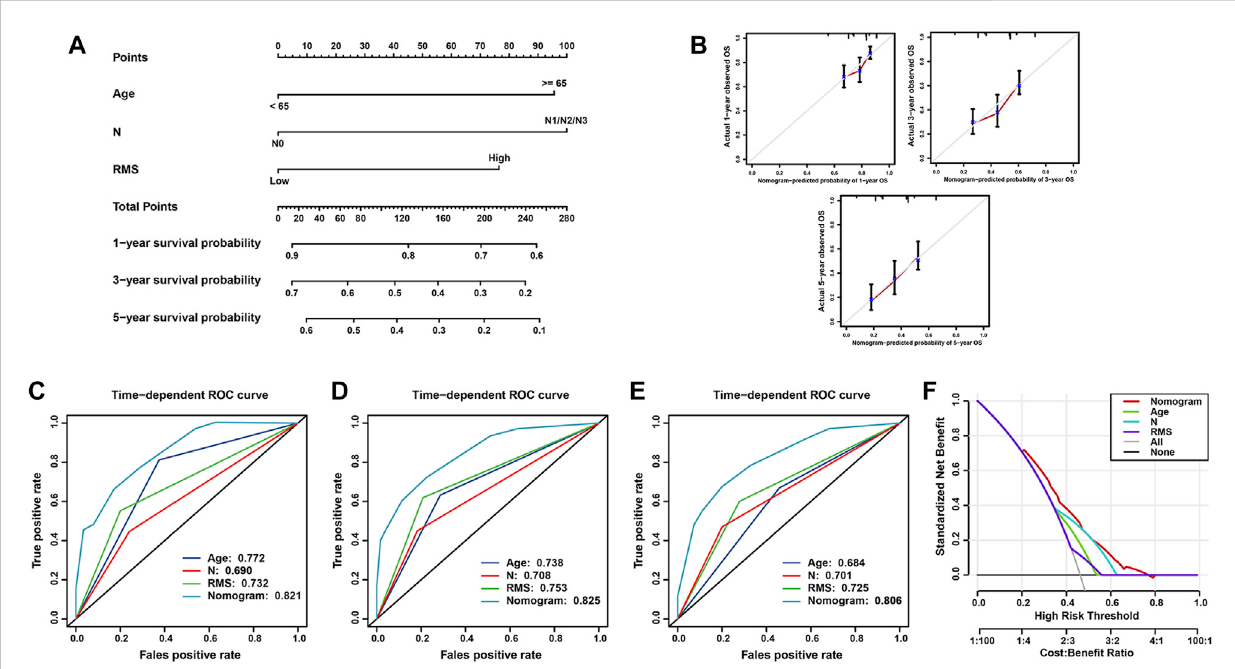
FIGURE 7 ConstructionandvalidationofnomogrammodelforsurvivalpredictioninBCa. (A) Nomogramforpredictingtheprobabilityof1-,3-,and5-yearOS for BCa patients. (B) Calibration curve of nomogram to assess the consistency between predicted and observed 1-, 3-, and 5- year outcomes. Time- dependent ROC curve ofthe nomogram, N classi fi cation, age and theRMS for (C) 1-year, (D) 3-year, and (E) 5-year OS ofBCa patients. (F) DCAcurvesof the nomogram model for BCa patients ’